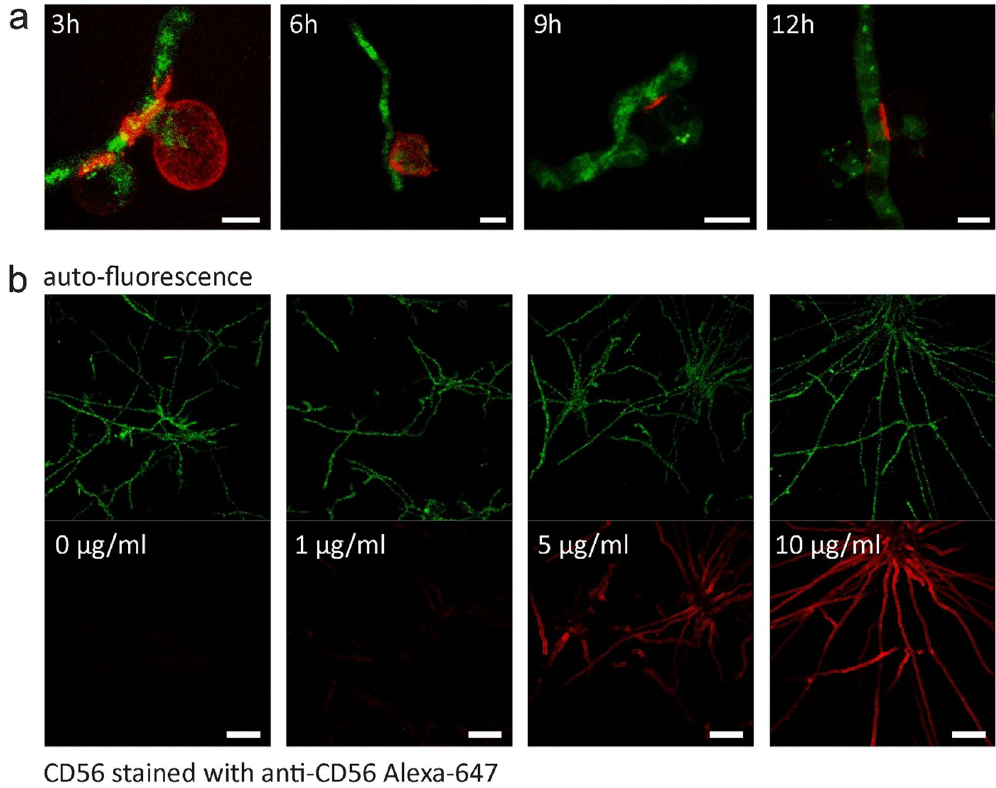
Figure 6. Time course of the NK cell -A. fumigatus interaction and direct binding of CD56 to the fungus. ( a ) NK cells were cultured with A . fumigatus germ tubes (MOI 0.5) for 3, 6, 9 and 12 h. CLSM pictures were taken from these co-cultures. ( b ) Fungal hyphae were incubated for 6 h with 0, 1, 5, and 10 μ g/ml soluble CD56 and were afterwards stained with anti-CD56 antibody. Alexa 647-labeled anti-CD56 antibody was used to visualize the distribution of CD56, while germ tubes could be detected via their auto fluorescence. Scale bars represent 5 μ m ( a ) and 30 µ m ( b